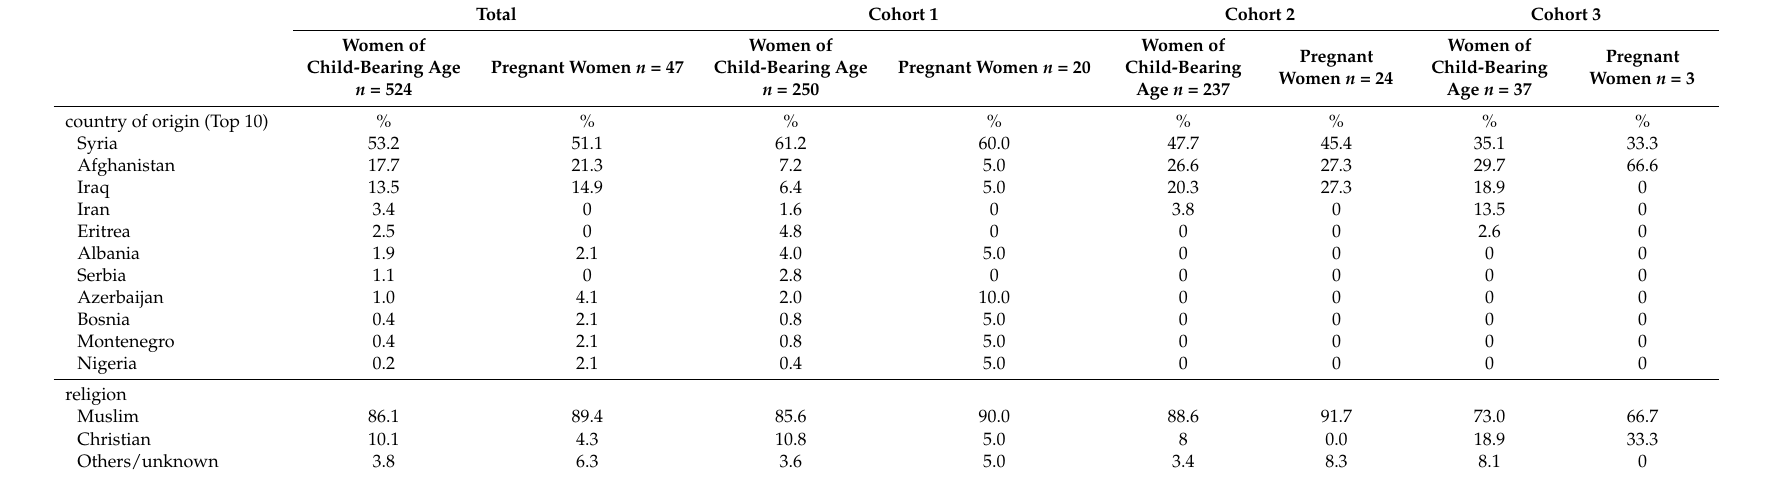
Table 1. Cohort-specific characteristics of women of childbearing age and pregnant refugees, country of origin and religion. Total Cohort 1 Cohort 2 Cohort 3 Women of Child-Bearing Age n =